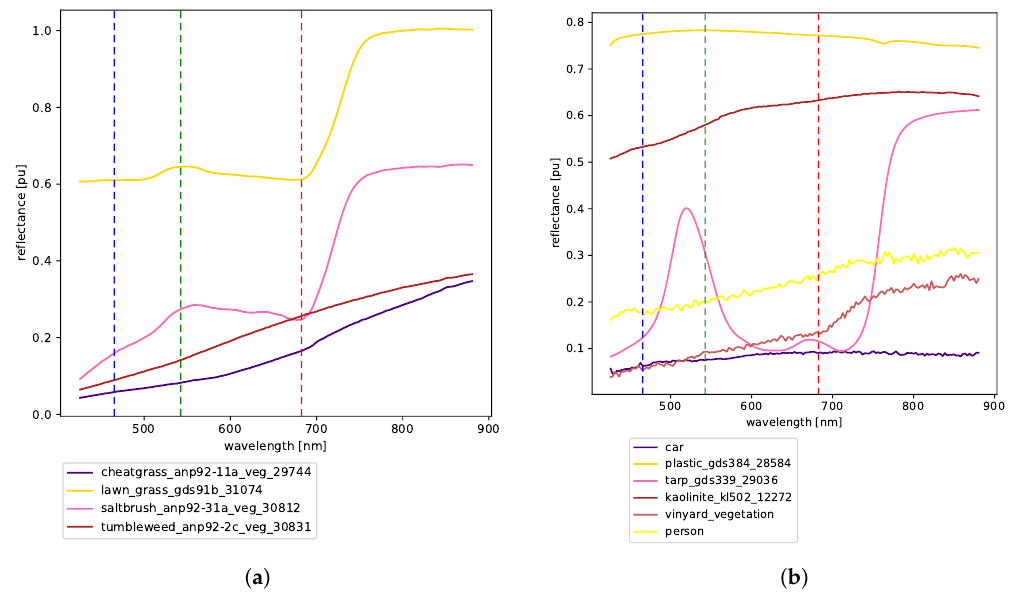
Figure 7. Background and anomaly spectra. ( a ) Background spectra; ( b ) anomaly